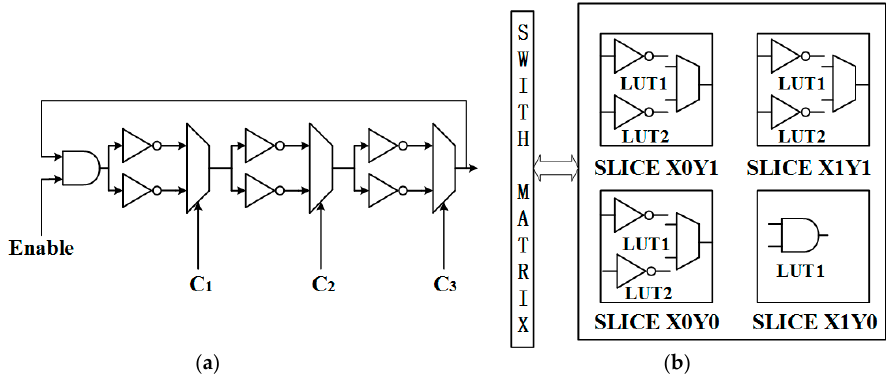
Figure 2. ( a ) Configurable RO ( b ) The configurable RO fits in a single configurable logic block (CLB) on a Xilinx Spartan 3E platform [11].